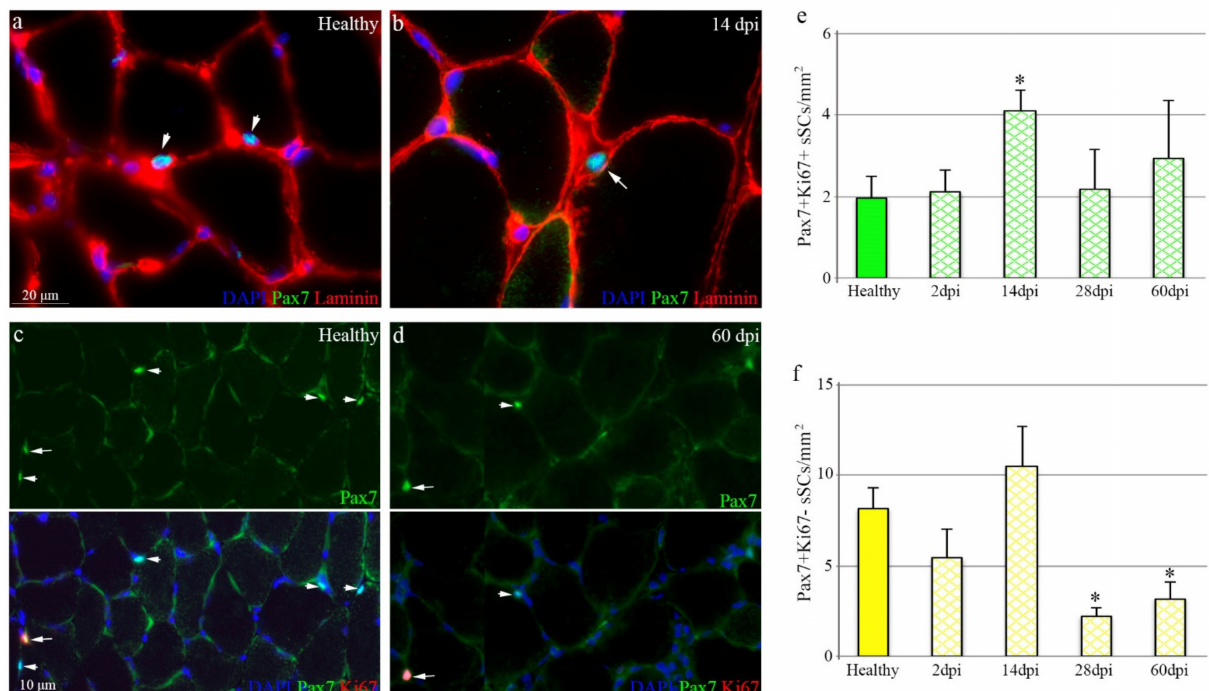
Figure 3. Satellite cell compartment is compromised after chronic tendon rupture. Representative muscle tissue sections from healthy and injured tendons immunostained for ( a , b ) Pax7/laminin and ( d , e ) Pax7/Ki67. Arrows and arrowheads indicate quiescent and activated/proliferating Pax7 + satellite cells, respectively. DAPI was used to identify all nuclei. Graphs show the number of total ( c ) Pax7 + Ki67 + and ( f ) Pax7 + Ki67 − satellite cells per µ m 2 in the muscles of experimental groups. Values are presented as the average of at least three independent experiments (mean ± SEM), where * designates significance ( p < 0.05) between muscles from healthy and injured tendons. ( n = 3, 2 dpi; n = 6, 14 dpi; n = 6, 28 dpi; n = 6, 60 dpi). dpi, days post